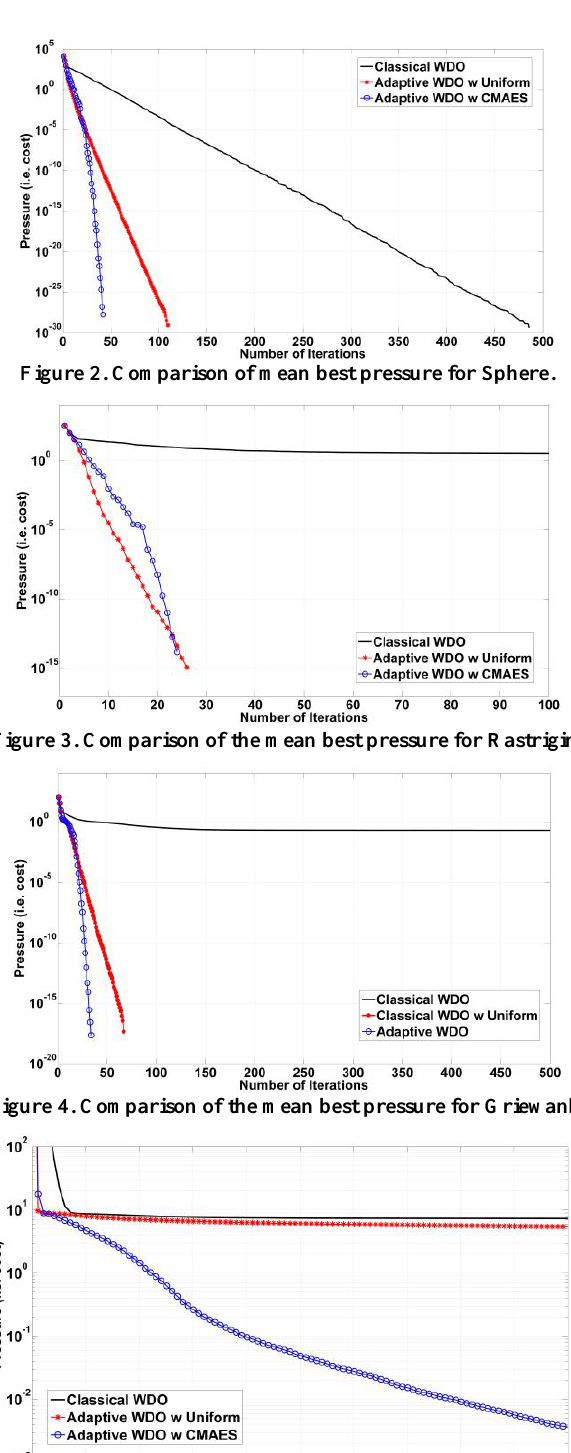
Figure 5. Comparison of the mean best pressure for